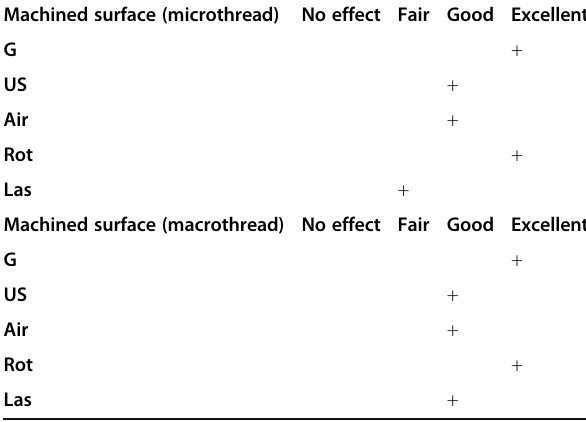
Table 2 Qualitative evaluation by SEM analysis of micro- and macrothread areas of machined surface